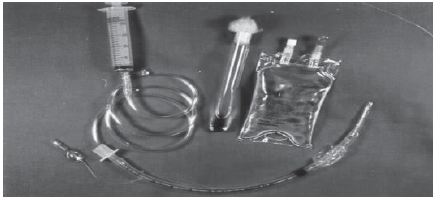
Figure 2 - Levine nº 14 catheters; 20 ml syringe; phosphate buffer solution (1ml/9ml); 10 ml of saline solutions; nº 7.5 orotracheal